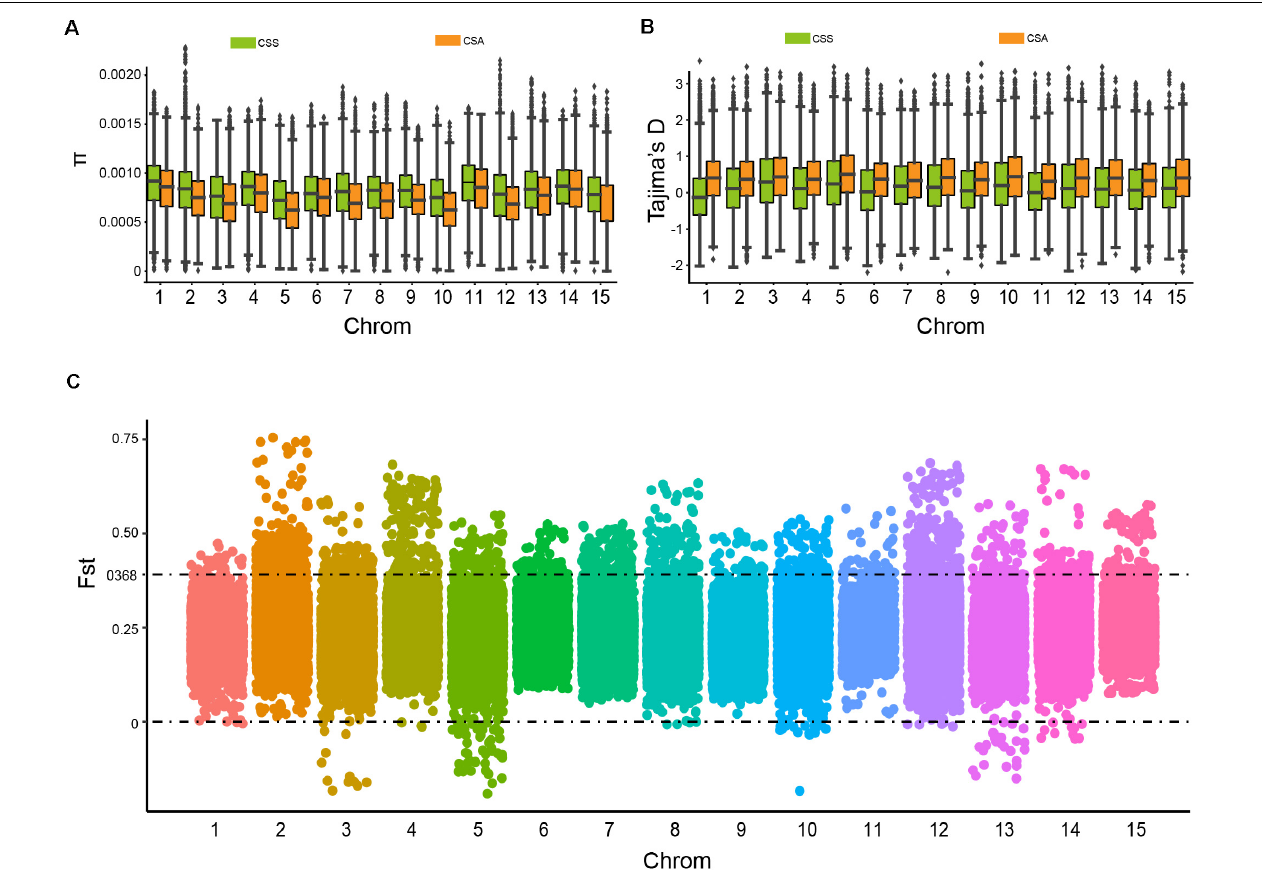
FIGURE 3 | The nucleic acid diversity ( π ), Tajima’s D value of CSS and CSA subgroups, and candidate differentiation regions identified in CSS and CSA subgroups on the genome. (A) Nucleic acid diversity. (B) Tajima’s D value. (C) Distribution of windowed Fst values for CSA versus CSS (window size 500 kb and step 50 kb), the dots above the dotted line represent candidate differentiation windows on the